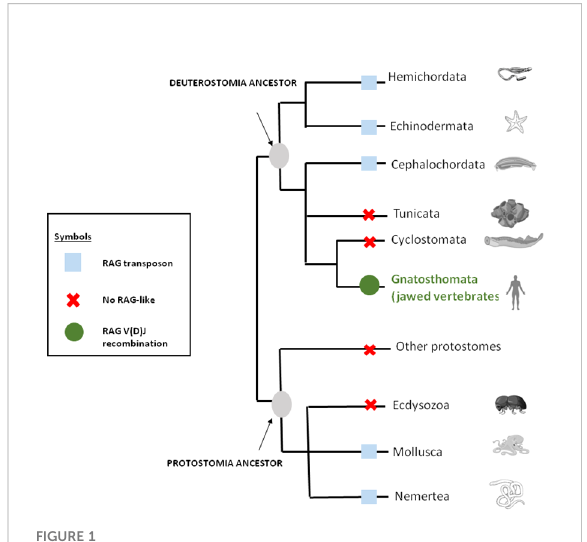
FIGURE 1 RAG through the eukaryote living world. The distribution of RAG across bilateral metazoans shows that RAG is originally a transposon that was domesticated in jawed vertebrates or gnatosthomes